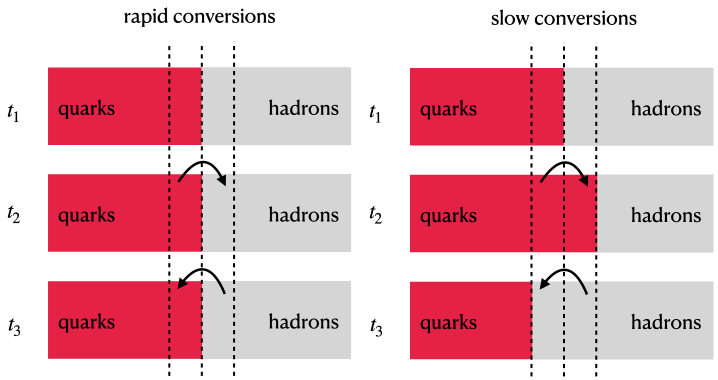
Figure 3. Neighborhood of the quark–hadron interface at three different times t 1 < t 2 < t 3 for rapid conversions ( left ) and slow conversions ( right ). At t 1 the interface is unperturbed; at t 2 a perturbation shifts a quark fluid element radially to a region with pressure below p tr . If the conversion timescale is smaller than the oscillation period, the fluid element converts into hadrons before returning to the region with p > p tr at time t 3 . If the conversion timescale is larger than the oscillation period, the fluid element has not enough time for converting into hadrons before returning to the region with p > p tr at time t 3